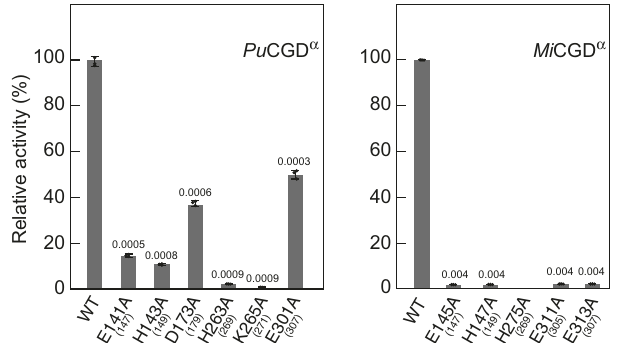
Fig. 6 Mutagenesis analysis of Pu CGD α and Mi CGD α . The numbers in brackets represent the corresponding numbers of the residues in Ag CGD2. All experiments were repeated independently more than three times, and similar results were obtained. Statistical comparisons between means for the wild type (WT) and each mutant were performed by Student ’ s t-test (2-tailed). The p -values were shown above each bar. The bars are means of n = 3 independent experiments (each data point was indicated by a black circle) and error bars indicate standard deviations. Data are presented as mean values + / − SD. All experiments were repeated independently three times with similar result and cause small errors in the coordination sphere of the metal ions in the crystal structure.